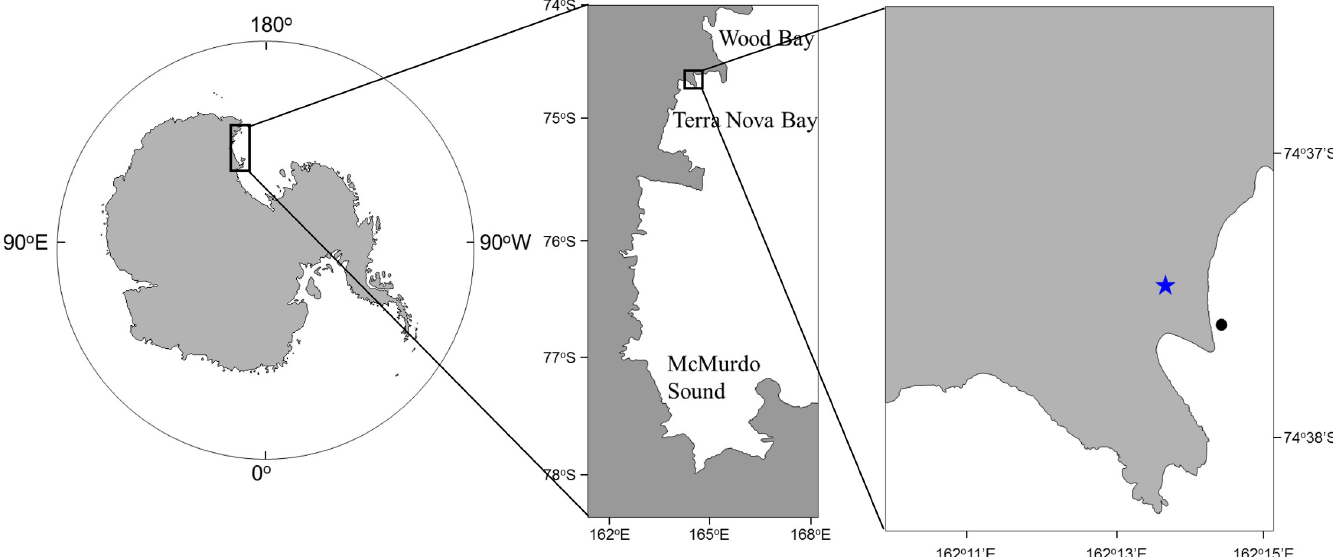
Fig 1. The study area and sampling site near the Jang Bogo Antarctic Research Station in Terra Nova Bay, Antarctica. Star indicates the Jang Bogo Station.